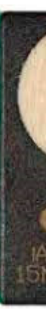
Figure 4. WINC1510 Wi-Fi module.